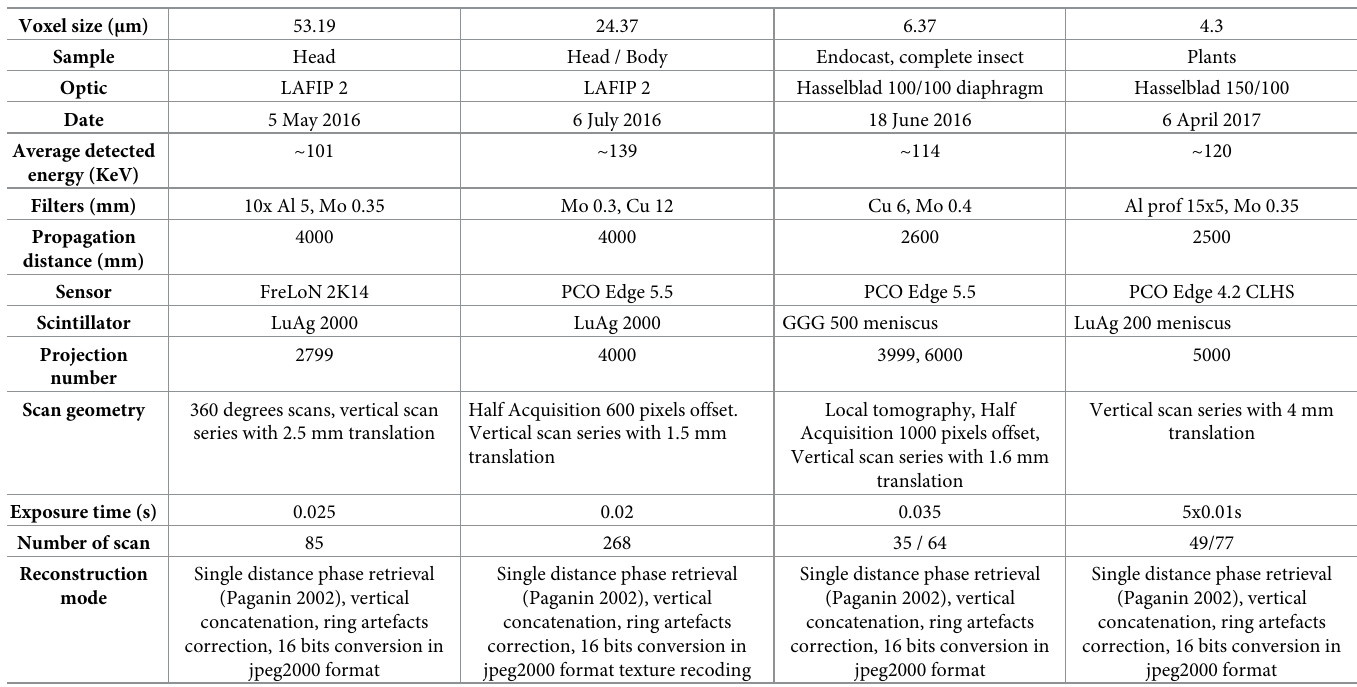
Table 1. PPC-SR μ CT data acquisition